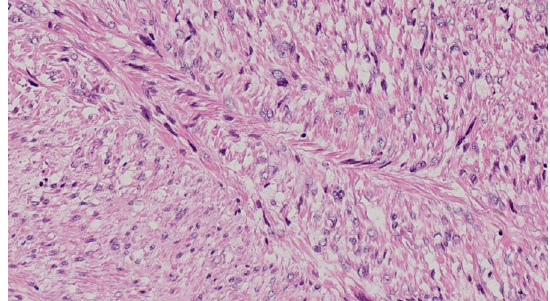
Fig. 1 A histopathological examination of the left forearm high-grade leiomyosarcoma showing dense proliferation of spindle-shaped cells with an eosinophilic cytoplasm and cellular atypia